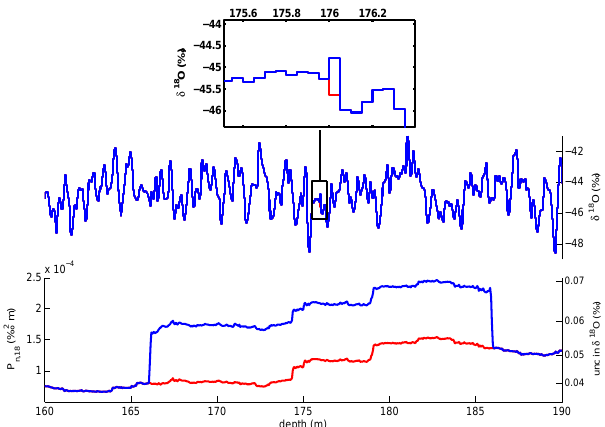
Figure 9. Part of the δ 18 O record (top figure) and the correspond- ing noise level (bottom figure) that is determined as the average PSD level for frequencies higher than 8cyclesm − 1 . The noise level is calculated with a window of 20m length. The sudden steps in the blue profile are caused by a single data point. Replacing this data point (see inset) by a value obtained by interpolating the neighbour- ing points leads to a much lower noise level (red